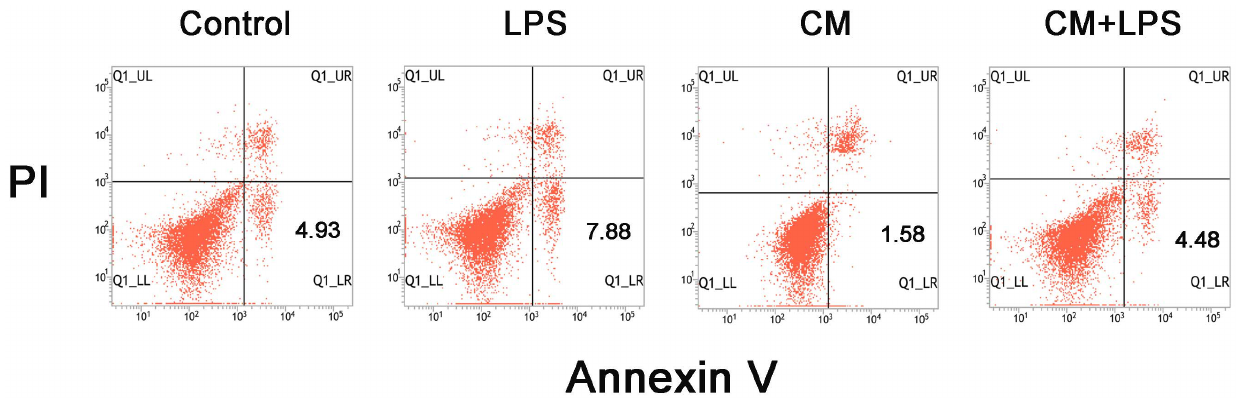
Figure 7. Apoptosis assessed by annexin V/propidium iodide (PI) assay. Annexin V/PI staining was performed to assess the apoptosis rate in microglia. After incubating in DMEM/F-12 or BMSC-CM with or without LPS (1 m g/mL) for 48 hours, microglia were harvested. Cells were then stained with annexin V-FITC and propidium iodide and analyzed by flow cytometry. The results are presented as density plots of propidium iodide vs. annexin V-FITC. Apoptotic cells have high annexin V-FITC and low propidium iodide staining (lower-right quadrant). Numbers on the graph represent the percentages of apoptotic cells in the different groups.